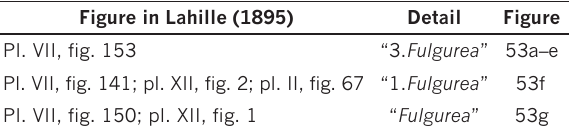
Table 23. Specimens of Voluta tuberculata fulgurea figured by Lahille (1895) with the detail of the inscriptions on their shells and figures here. Figure in Lahille (1895) Detail Figure Pl. VII, fig. 153